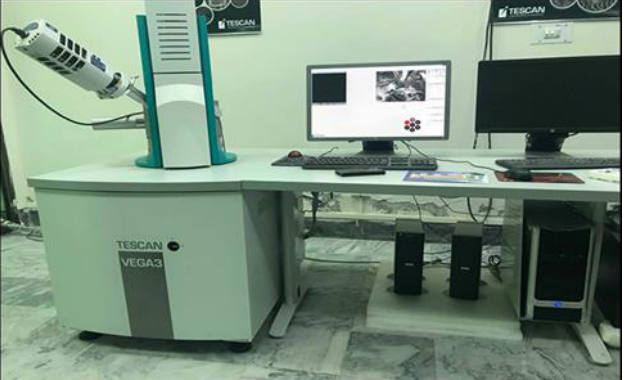
Figure 3. The Scanning Electron Microscope (SEM) in the Mechanical Engineering Department (University of Engineering and Technology, Taxila). Appl. Sci. 2019 , 9 , x FOR PEER REVIEW